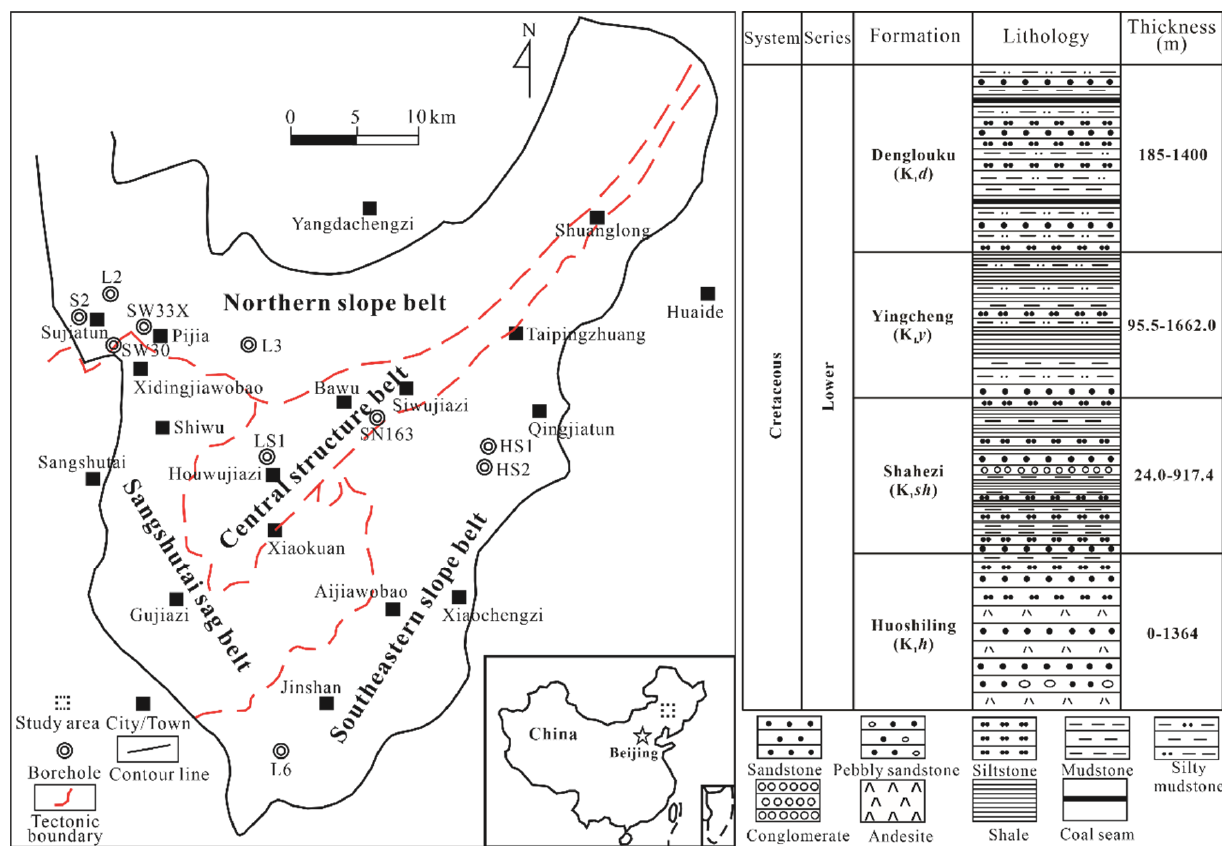
Figure 1. Location map and stratigraphic column of the lower Cretaceous formations in the Lishu Fault Depression.